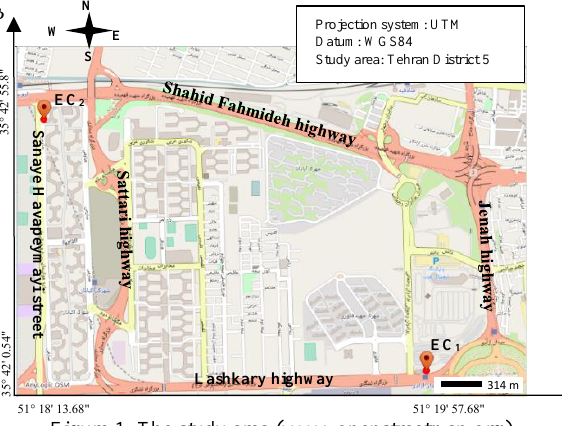
Figure 1. The study area (www.openstreetmap.org) The population of each block is determined by the proportion of the area of the block to the area of the statistical zone. For the implementation of AMWNVD, the central axis of the urban street network was drawn in AutoCAD map software. Also, the historical travel time data of urban street network achieved from Municipality of Tehran Transport and Traffic company. The travel time data are collected in 2017 in the shape file format. As mentioned, travel time and length of streets were used in finding the ambulance optimum path. The street network of the Tehran Control Traffic